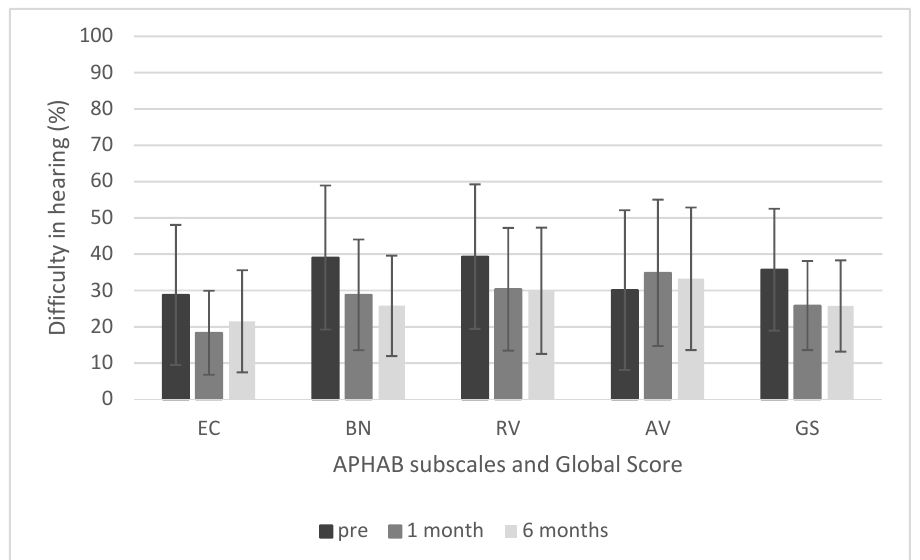
Figure 9. Results of APHAB questionnaire.EC, Ease of Communication; BN, Background Noise; RV, Reverberation; AV, Aversiveness; GS, global score. The differences in the EC, BN, and RV subscales are statistically significant at p < 0.05, but the difference in the AV subscale is not. The bars represent mean scores, the error bars represent standard deviations.